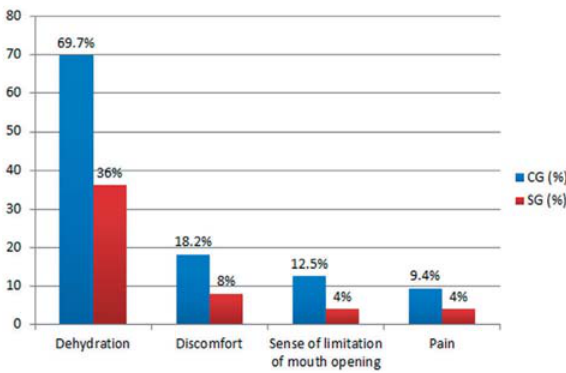
Figure 1- Symptoms of 57 patients